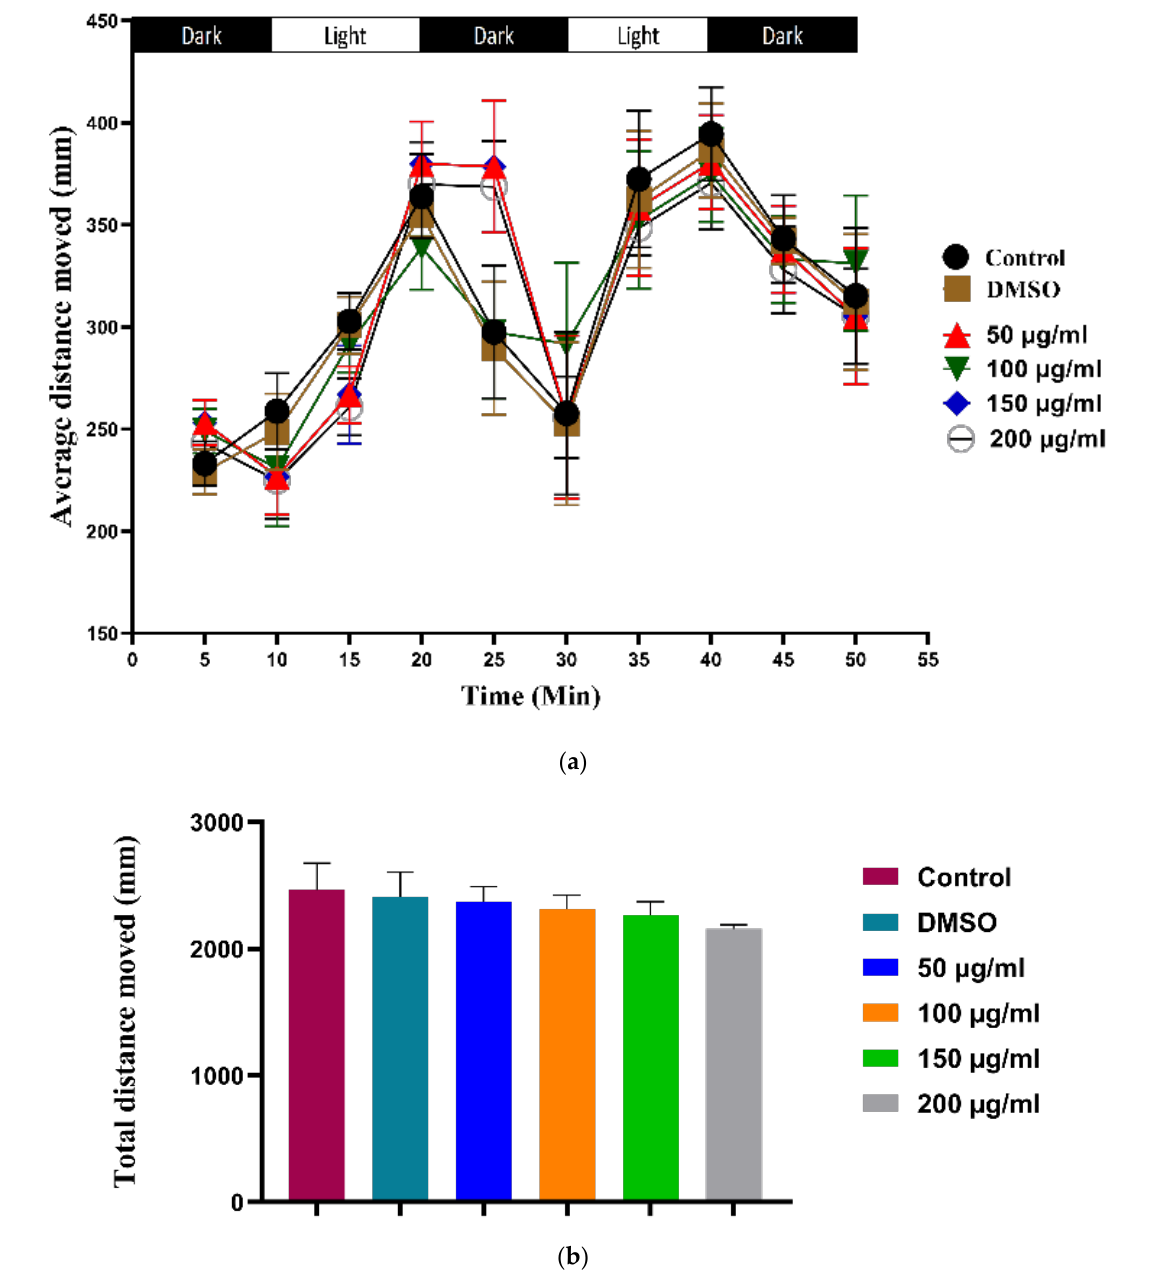
Figure 5. Behavioral and locomotion assays of the experimental group at 96 h post-fertilization. ( a ) Average distance moved by embryos; ( b ) Total distance moved by embryos. Data of the locomotion test are represented as mean ± SEM. (20 embryos were used in each group; the experiment was performed in triplicate). The analysis was done by a two-way-ANOVA test.